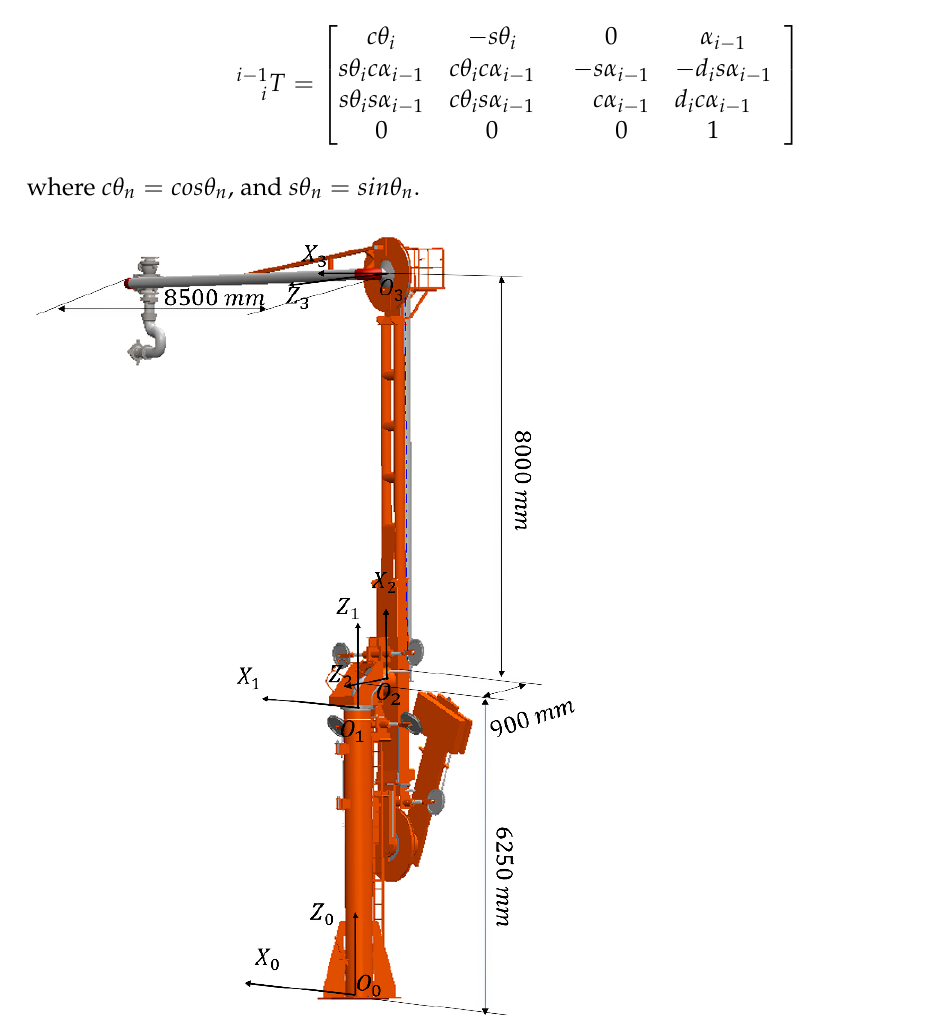
Figure 11. Coordinate system diagram of LNG marine loading arm link.